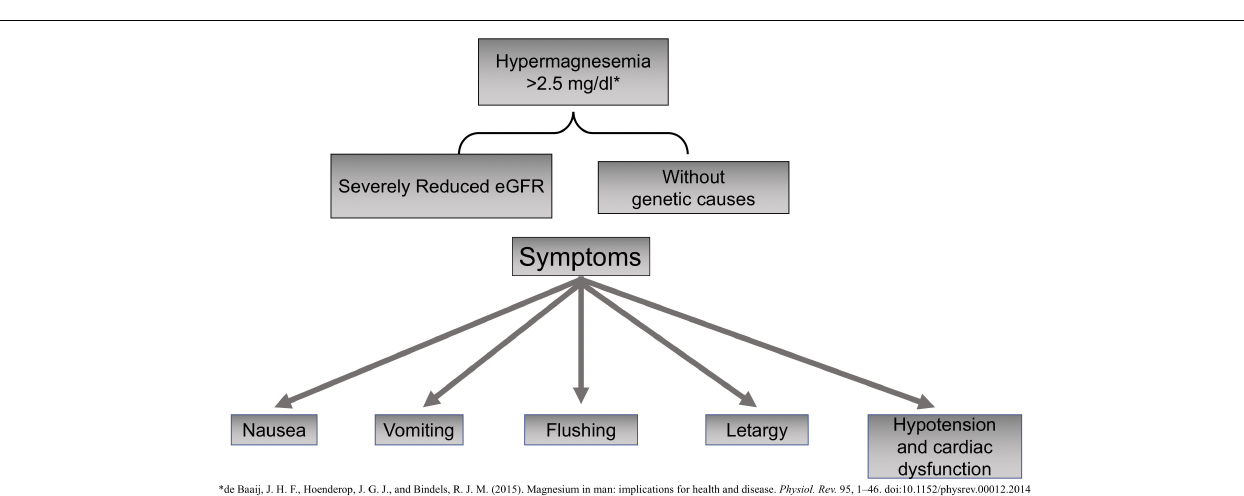
FIGURE 2 | Causes and Symptoms of